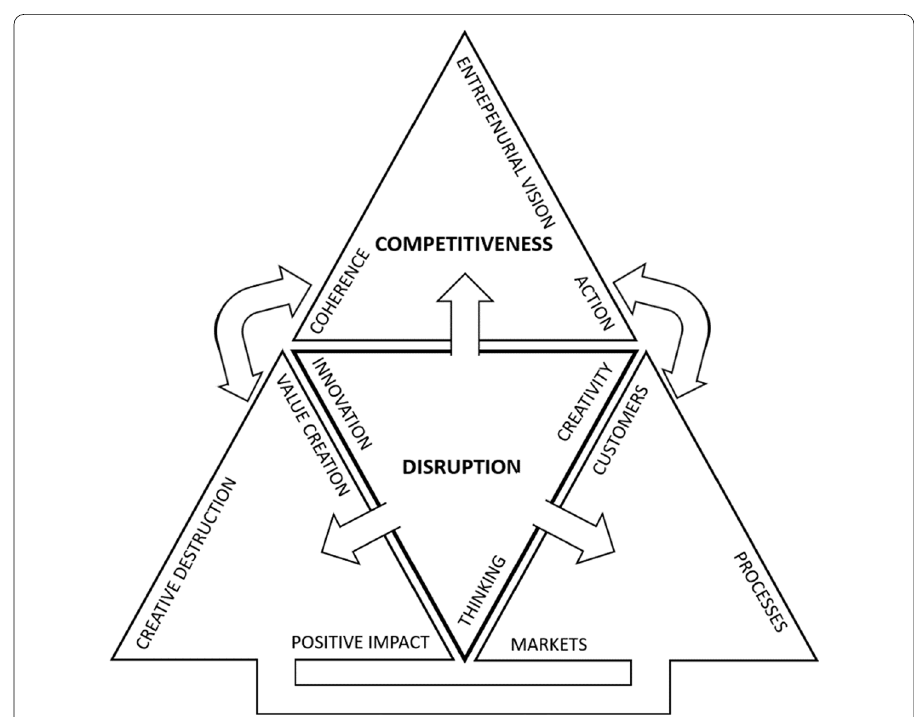
Fig. 1 Disruptive triad and its relationship with competitiveness (theoretical proposed model). Elaborated by Félix Socorro, May